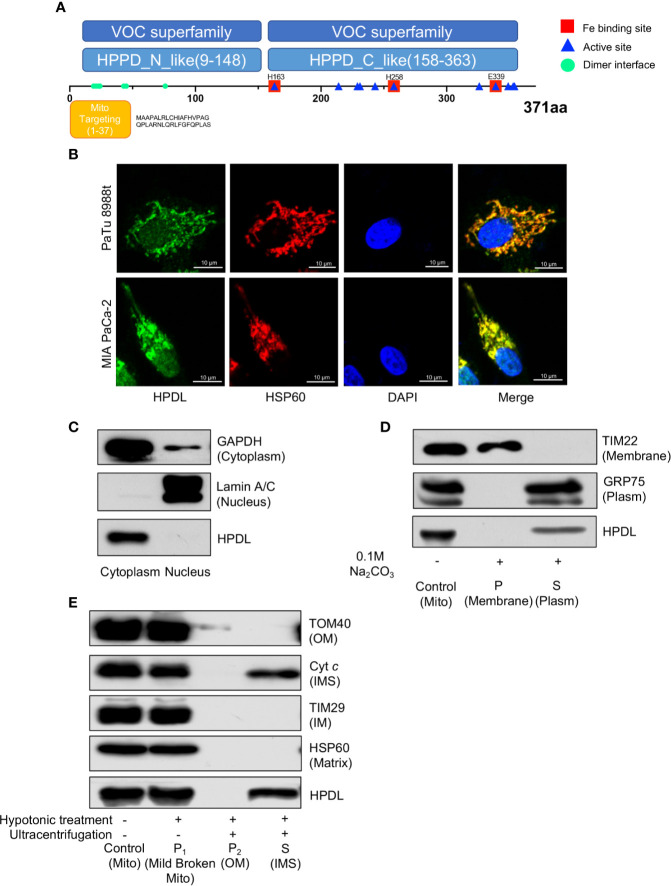
HPDL localizes to mitochondrial intermembrane space. (A) Schematic diagram of HPDL protein domain structure. HPPD_N_like and HPPD_C_like, C-terminal or N-terminal domain of 4-hydroxyphenylpyruvate dioxygenase (HppD) and hydroxymandelate synthase (HmaS). (B) Immunofluorescence colocalization analysis of HPDL in PaTu 8988t and MIA PaCa-2. Cells were immunolabeled with HPDL (Alexa flour 488, green) and HSP60 (Alex flour 594, red), and nuclear was stained with DAPI (blue). (C) Subcellular fractionation analysis of HPDL in MIA PaCa-2. Cytosolic and nuclear protein was extracted and immunoblotted with antibodies as indicated. (D) Carbonate extraction analysis of HPDL in MIA PaCa-2. Isolated mitochondria were subjected to 0.1 M Na2CO3. Mitochondrial proteins in membrane and plasm was separated with ultracentrifugation. Proteins were separated with SDS-PAGE and immunoblotted with antibodies as indicated. Mito, isolated crude mitochondria. P, pellet. S, supernatant. (E) Submitochondrial fractionation analysis of HPDL in MIA PaCa-2. Isolated mitochondria were subjected to hypotonic buffer (10 mM HEPES/KOH, pH 7.40) to break the integrity of mitochondrial outer membrane. Mild broken mitochondria were separated with low-speed centrifugation. Proteins in mitochondrial outer membrane and intermembrane space were subsequently separated with ultracentrifugation. Proteins were separated with SDS-PAGE and immunoblotted with antibodies as indicated. Mito, isolated crude mitochondria. P1, pellet in first centrifugation. P2, pellet in second centrifugation. OM, outer membrane. S, supernatant in second centrifugation. IMS, intermembrane space.